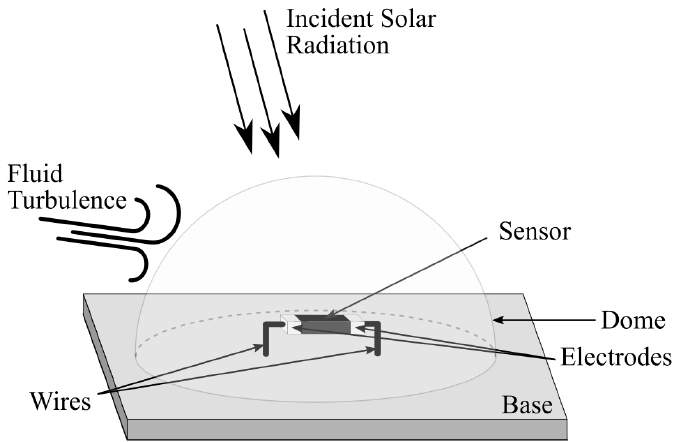
Figure 1. The sensor module used in Electrical Equivalence